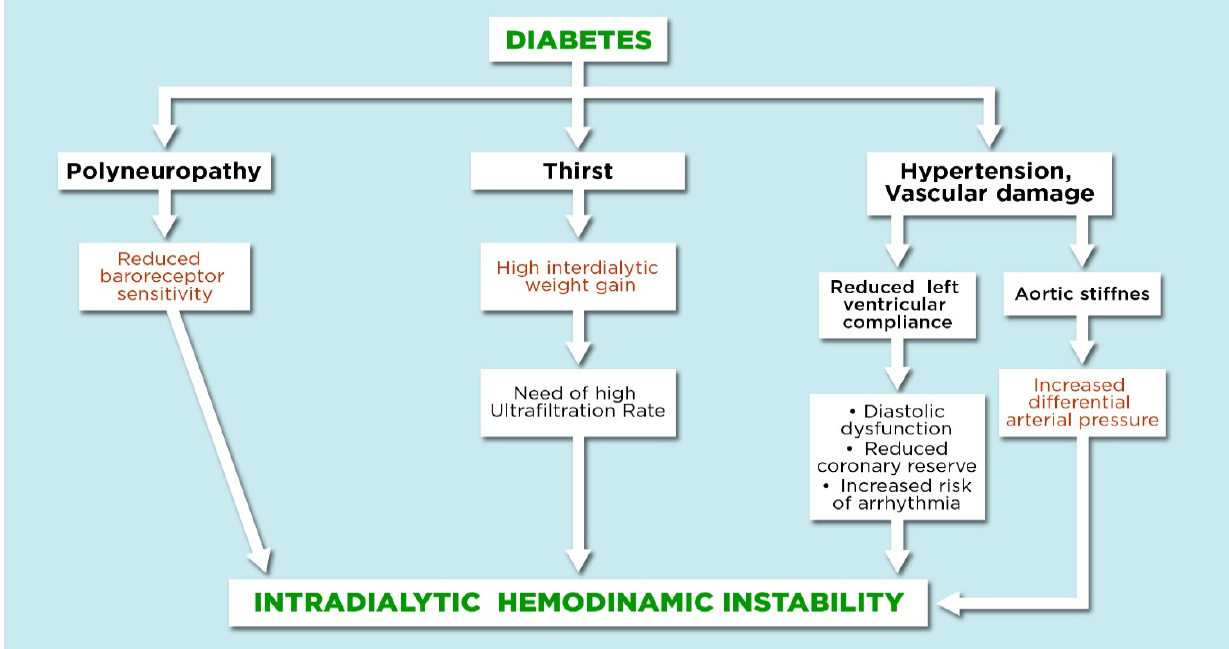
Figure 1. Schematic representation of the main conditions that, together, trigger the phenomenon of hemodynamic instability during HD in patients with diabetes.